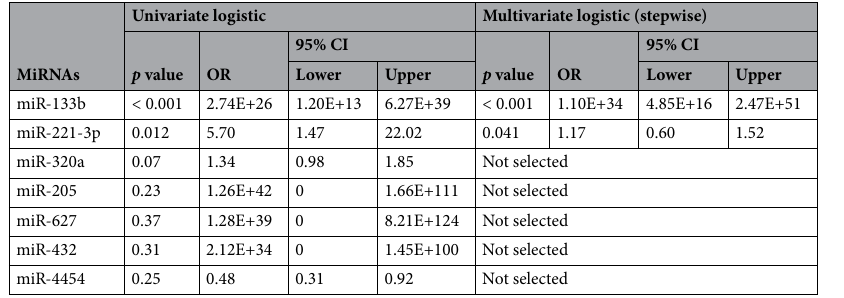
Table 5. Univariate and multivariate logistic regression analyses of candidate plasma miRNAs in predicting Parkinson’s disease from healthy controls.